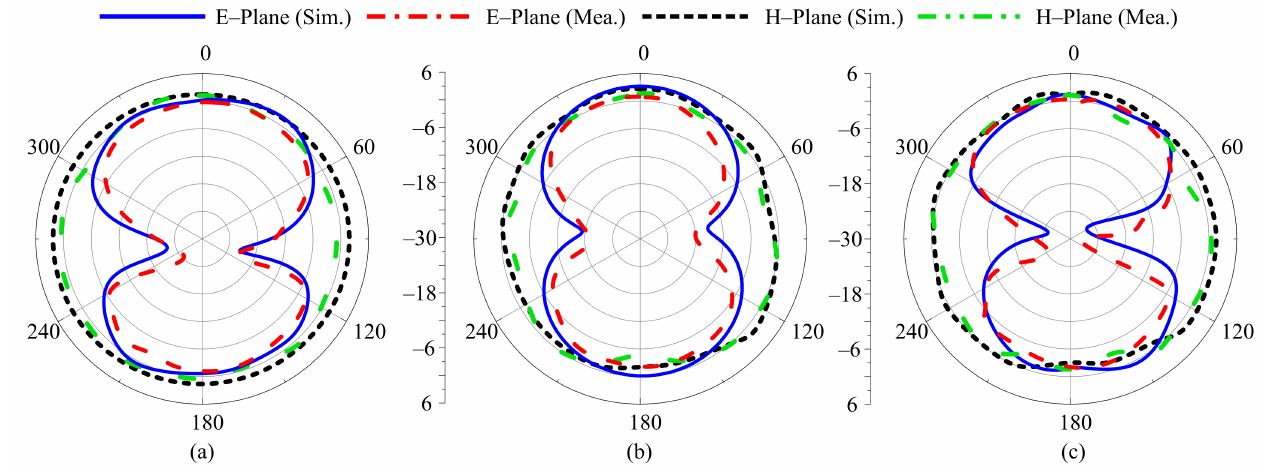
Figure 13. Simulated and measured radiation pattern of proposed antenna at 2.45 GHz for Case-100.